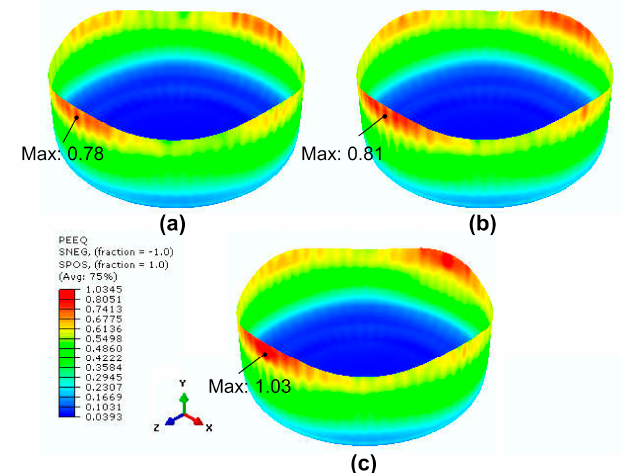
Figure 10. Results of the earing height profiles of AA1050-O using the present finite element analysis (FEA) with uniform BHFs of 1 kN, 3 kN, and 5 kN.